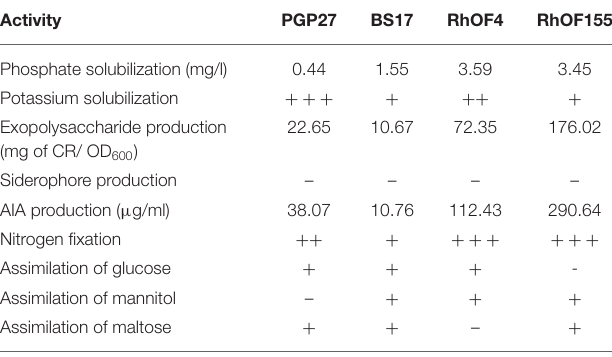
TABLE 1 | Characteristics of the tested rhizobacteria (Raklami et al., 2019). Activity PGP27